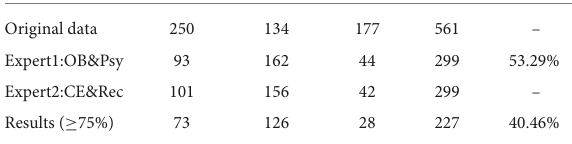
TABLE 3 Descriptive statistics of evaluation results.